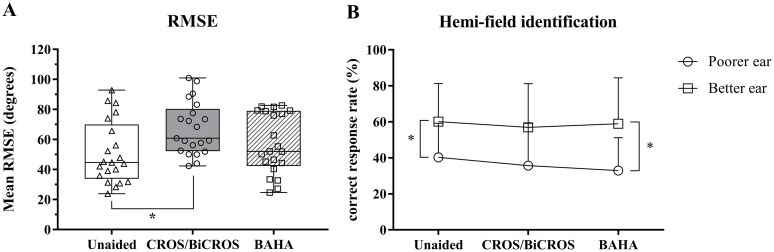
Localization results.Panel A shows the mean RMSEs for the three listening groups (unaided, aided with CROS/BiCROS, and aided with BAHA). Panel B shows the hemifield identification scores of the three listening groups. The hemifield identification score was calculated by counting the correct responses when the speaker identified by the listener was in the correct half of the loudspeaker array. Loudspeaker location was categorized as either on the poorer ear side or the better ear side. Error bars indicate SD. Asterisks (*) indicate significant differences, p < 0.05.